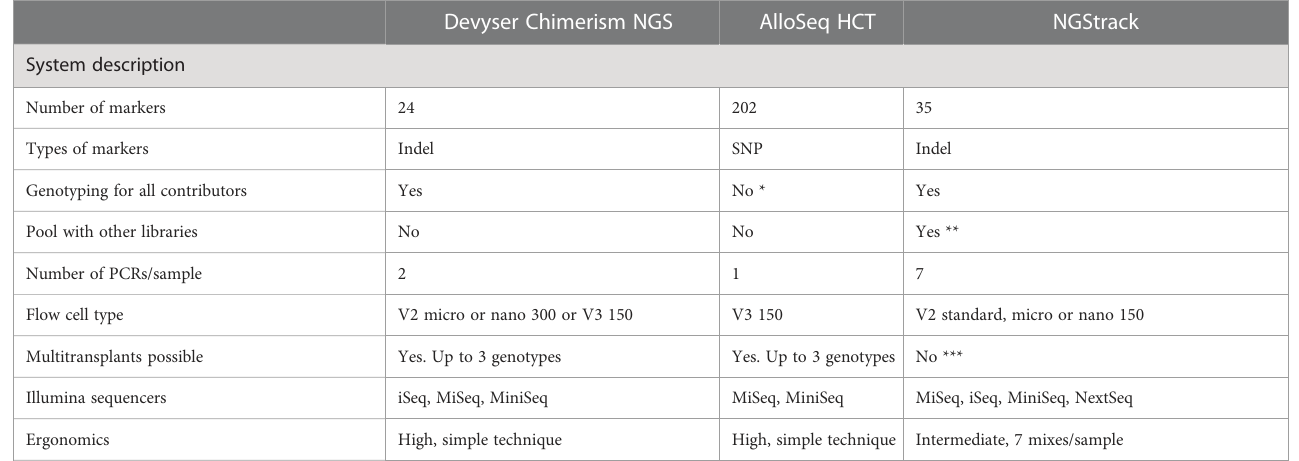
TABLE 3 Comparison of NGS methods for chimerism analysis. +++: very easy, ++: easy, +: less